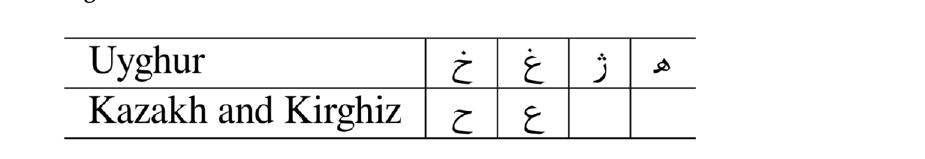
Figure A7. Common characters.